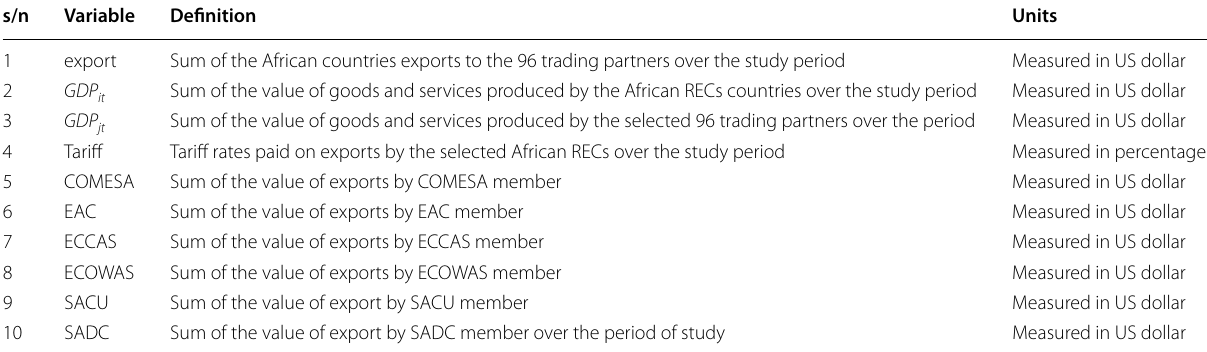
Table 9 Variable description. Source : export, COMESA, EAC, ECCAS, ECOWAS, SACU, SADC were sourced from IMF (2020) while the GDPs and Tariff were sourced from WDI [26]